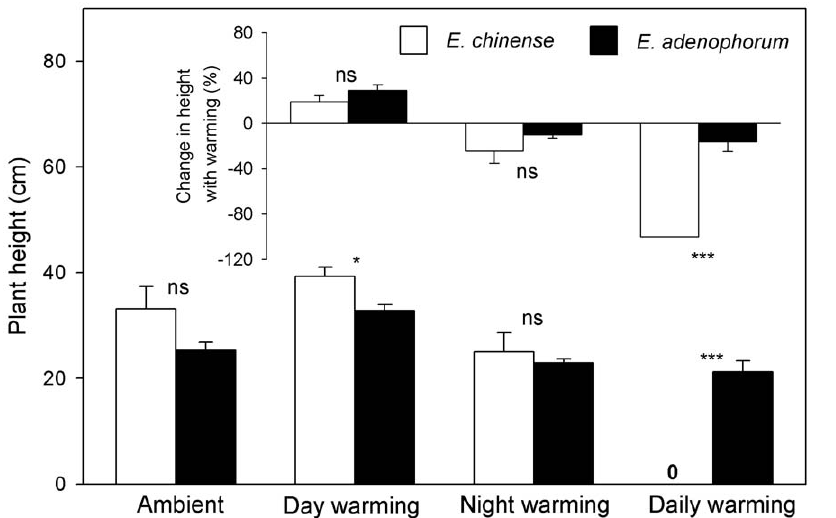
Figure 1. Plant height of the invasive plant Eupatoriumadenophorum and the native plant Eupatoriumchinense grown in four different air temperatures, and changes in plant height with warming for both species (embedded smaller panel inside). Data are